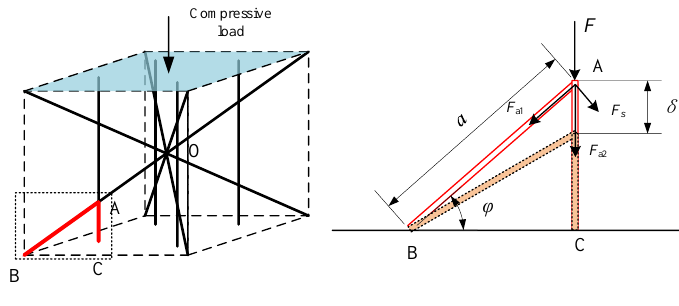
Figure 2. Stress condition of BCC4IZ under compressive